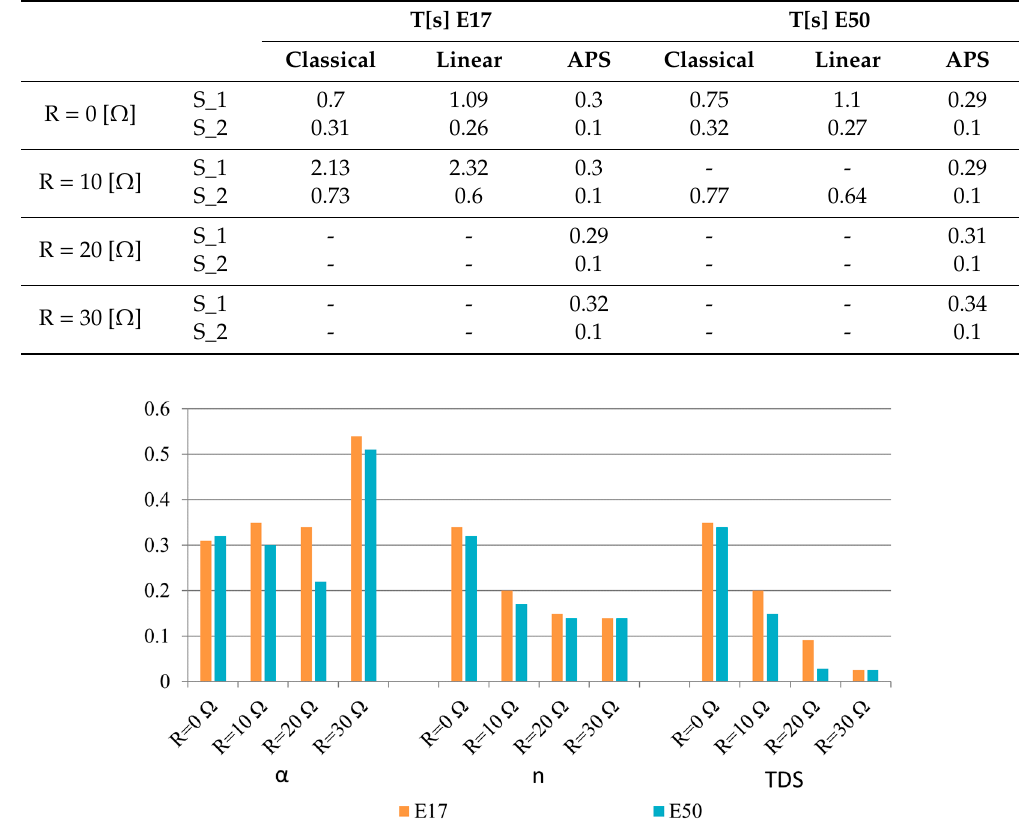
Table 7. Operation time comparison (classic, linear programming, and smart-sensor APS coordination) for different DG penetration levels: Scenario E.